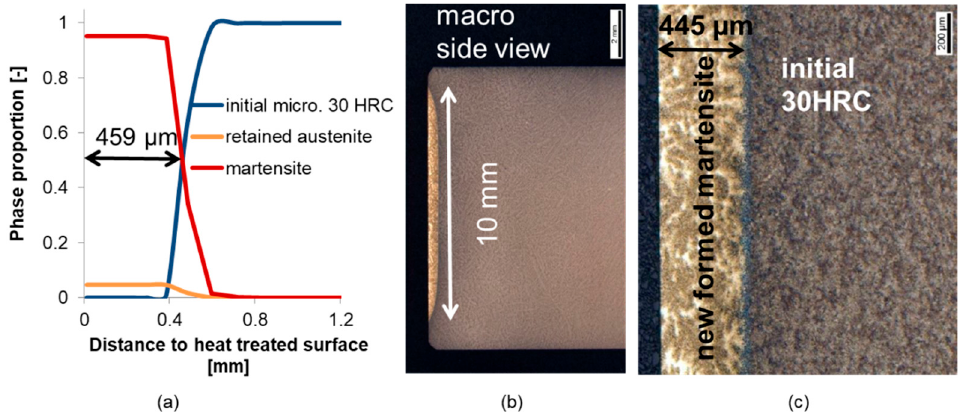
Figure 9. ( a ) simulated phase amounts. ( b , c ) micrographs of the workpiece with QT 30HRC . Experiment with l g = 1.48 mm,